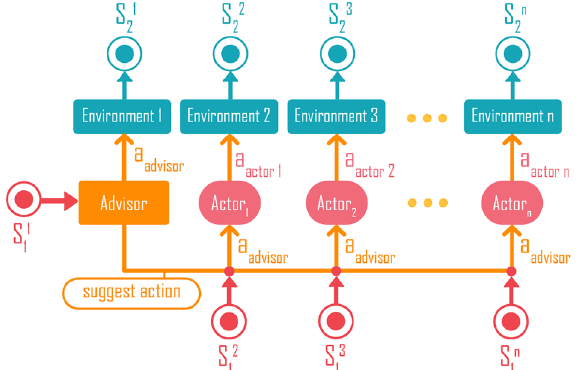
Figure 9. MSD includes a novel component called the advisor. The advisor is a special actor, trained with data from the Sample Extraction Buffer (SEB). The advisor provides suggestion to the actors (there are multiple actors exploring the environment at the same